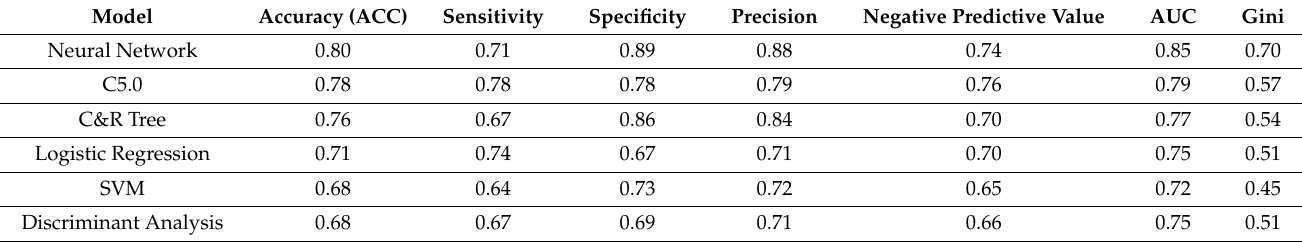
Table 2. Results of the classification performance of different models using the training EMG